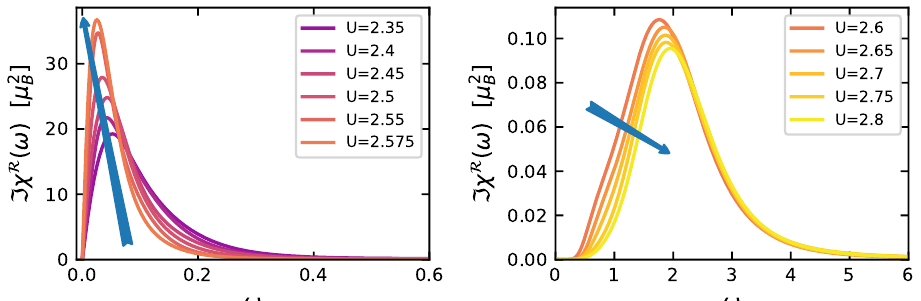
Figure 4: Absorption part of the local spin spectral functions obtained by analytically continuing the DMFT spin-susceptibilities for different U values at T = 1 / 200 in the metallic phase (left) and the insulating phase (right). Notice the different axis-scales used in the two